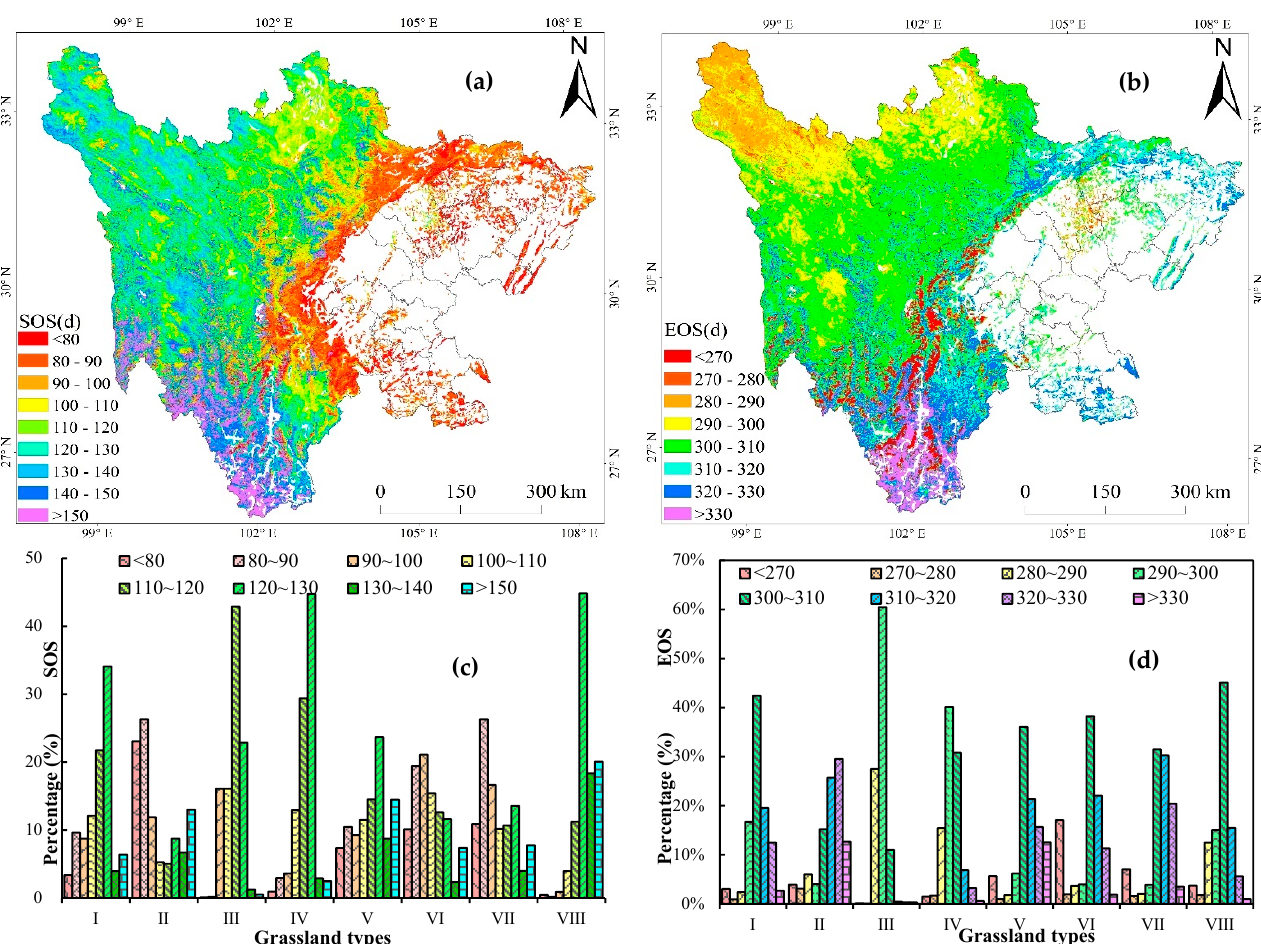
Figure 3. Spatial distribution of annual mean phenological values (( a ) Start of the season and ( b ) End of the season) and vegetation percentages (( c ) Start of the season and ( d ) End of the season) of the eight grassland types ( Ⅰ : shrub; Ⅱ : steppe; Ⅲ : tussock; Ⅳ : meadow; Ⅴ : coniferous forest; Ⅵ : coniferous and broad-leaved mixed forest; Ⅶ : deciduous forest; Ⅷ : alpine vegetation) in the Sichuan Province from 2001–2020.